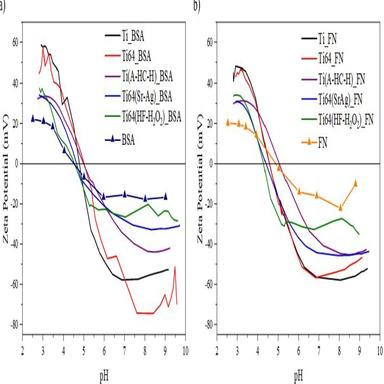
Zeta potential titration curves of untreated and treated titanium surfaces after adsorption of albumin (a) and fibronectin (b). The curves of the respective proteins in solution are also reported.